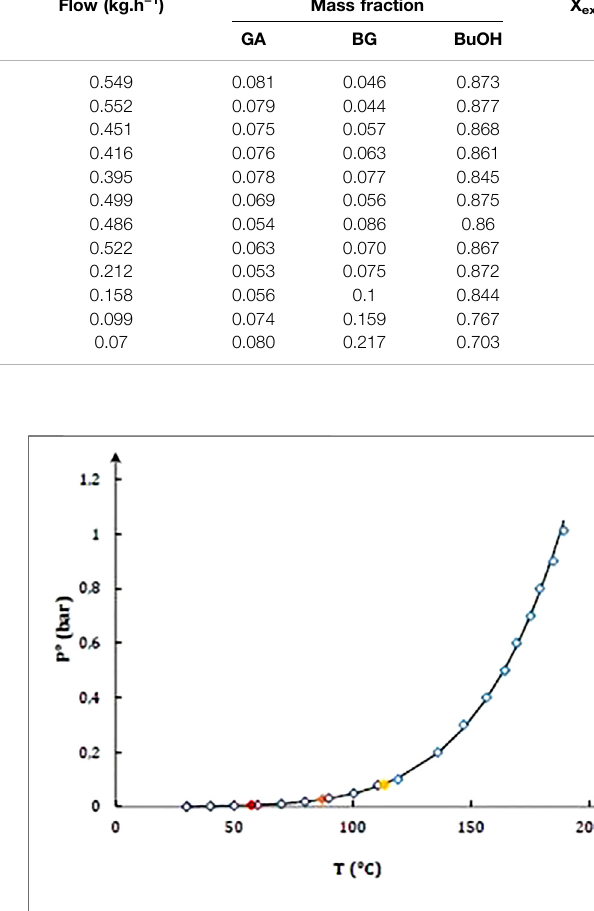
TABLE 1 | Operating conditions for reactive distillation and results obtained with m AG /m BuOH 1/10 g/g. Feed Boiler Mass fraction F (kg h − 1 )